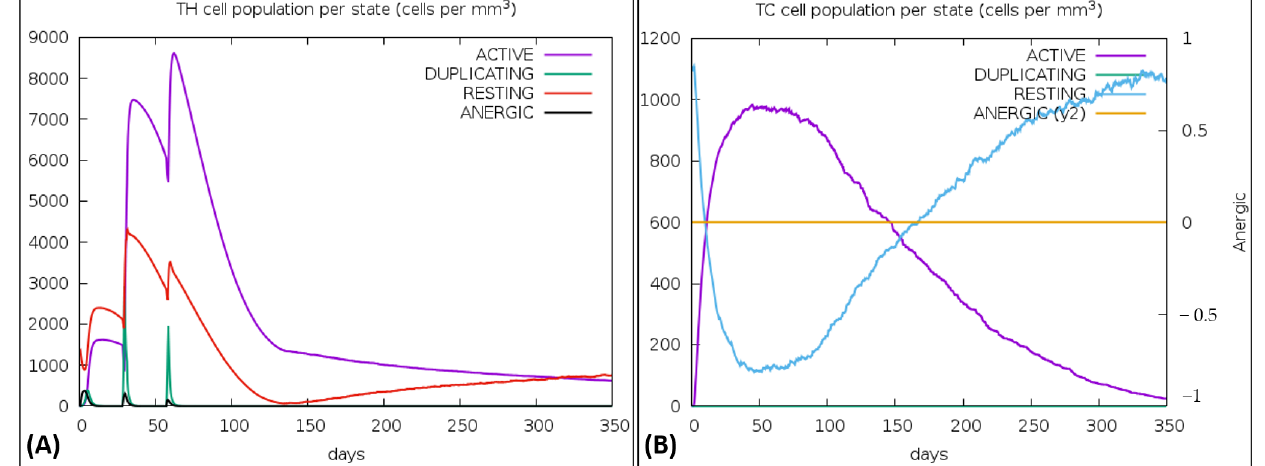
Figure 9. ( A ) Representation of regulatory T-cell production in immune response, ( B ) Graph showing the sharp rise in Cytotoxic T-cells.